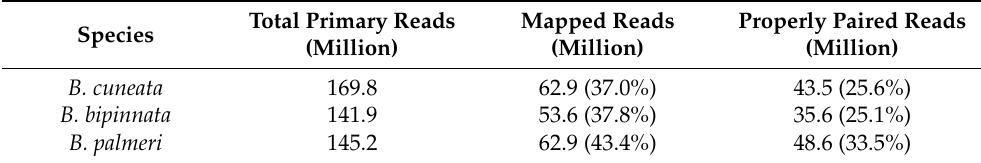
Table 2. Alignment and mapping of the preprocessed filtered reads of the three Bursera species against the nuclear genome of Bowsellia sacra .